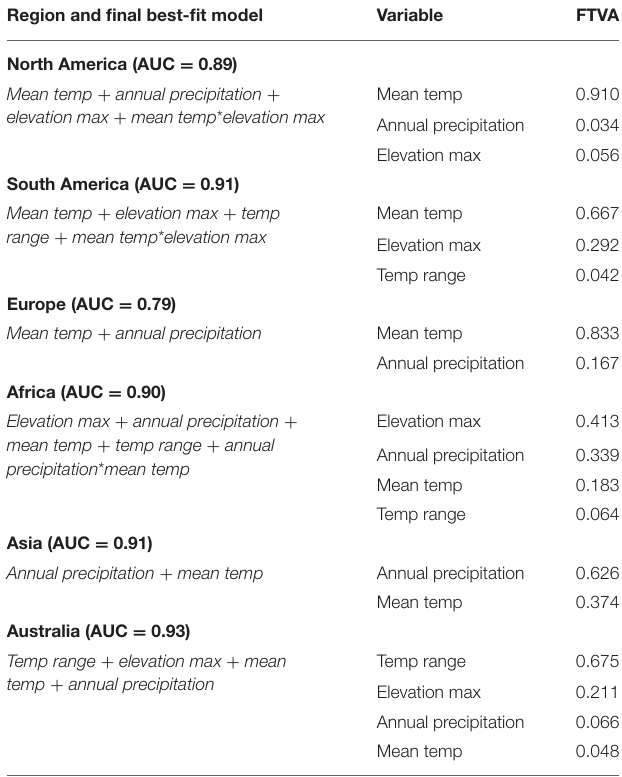
TABLE 5 | Final best-fit model covariates of regional presence-only species distribution models (North America, South America, Europe, Africa, Asia, Australia), including regional model area under the curve (AUC), and fraction of total variation accounted for (FTVA) for each variable. Region and final best-fit